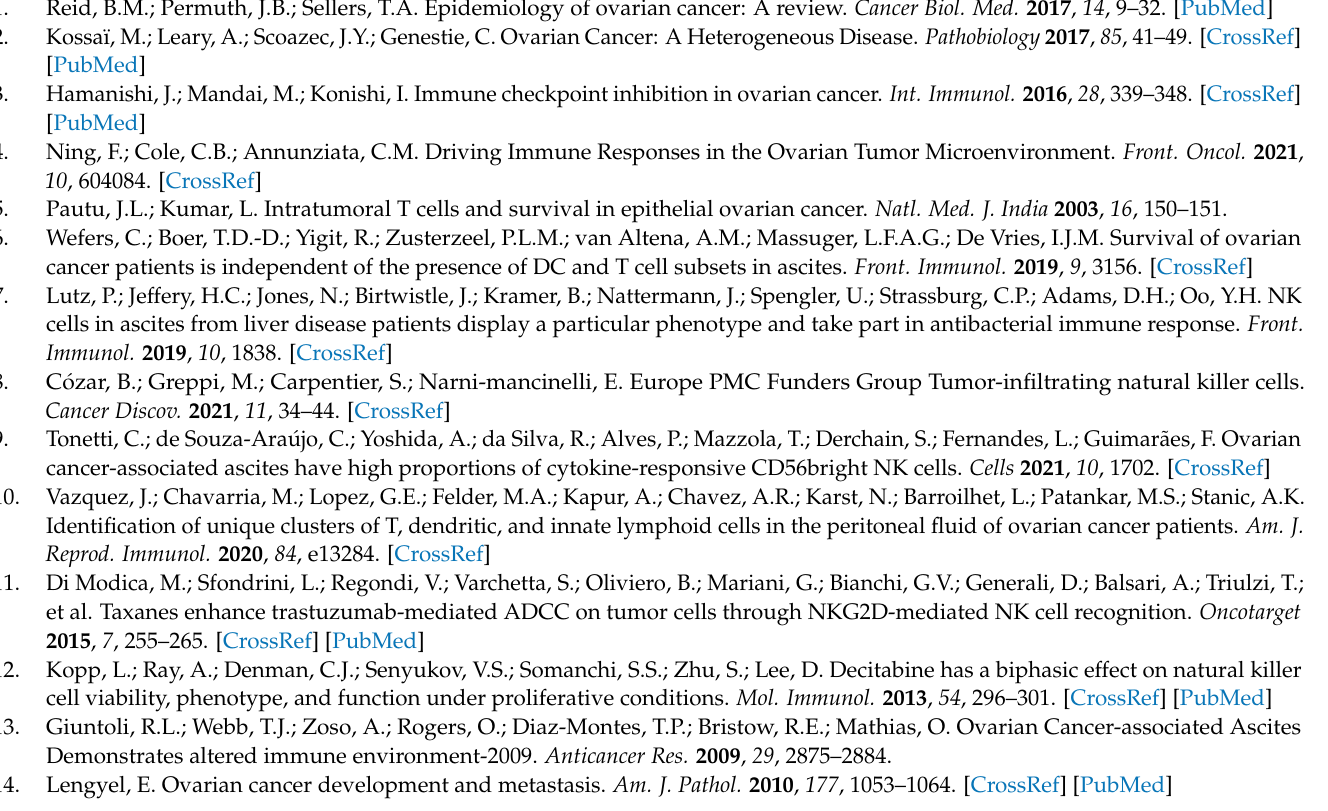
Table S1: Details of antibodies used in the